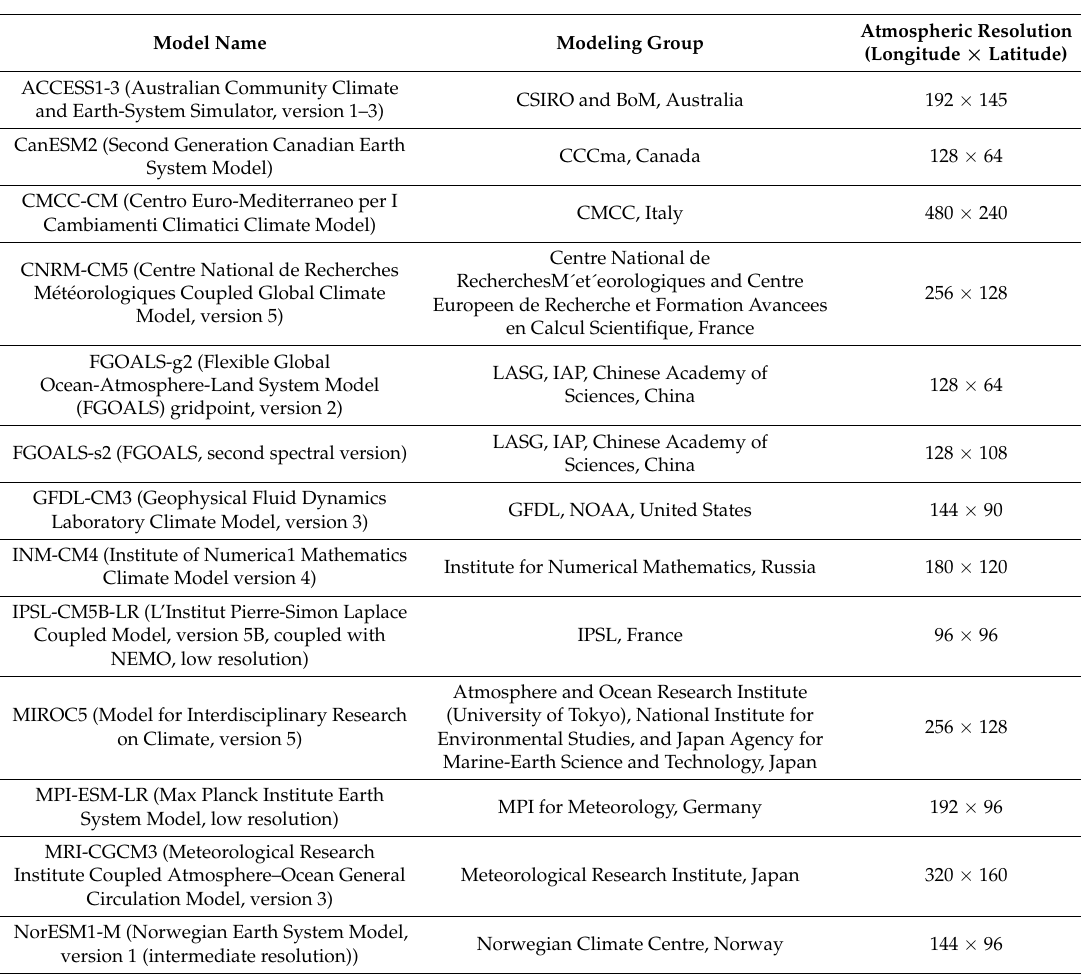
Table 1. List of 13 selected Coupled Model Intercomparison Project (CMIP) phase 5 (CMIP5) climate